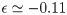
An example of weak but very long–range negative epistasis with ϵ≃−0.11.Individual mutations Q25 (orange) → E25 (red) and E6 (red) → G6 (green) in panels (B) and (C) are slightly deleterious and neutral, with ΔP1≃−0.11 and ΔP2≃0 respectively (ΔP12≃−0.22). E6 is ordered (Q25 is disordered) in the initial ensemble, and E25 is ordered (G6 is disordered) in the single mutant ensembles. In the double mutant, the removal of E6 allows E25 to form favorable contacts with other charged monomers during folding, which leads to more frequent mis–folding of the binding site, frustrating the exchange of material between ordered and disordered phases. The distance between mutated positions in panel (A) is R≃12.5 Angstroms. Folded ensembles for the initial and mutated sequences are shown in S8 Fig.